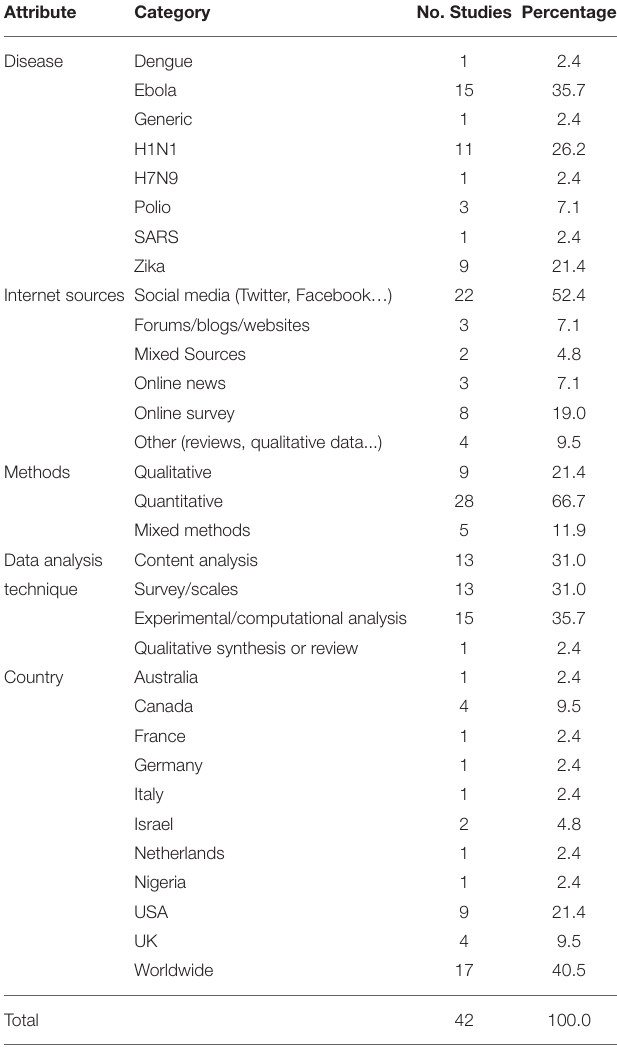
TABLE 1 | Number of documents and its attributes.